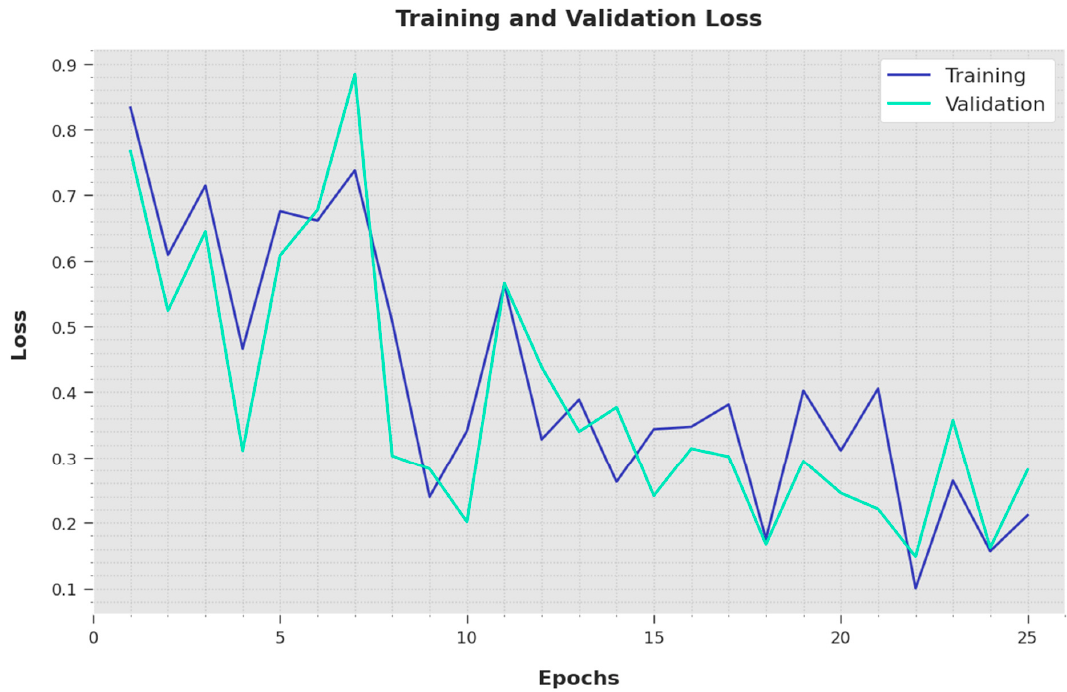
Figure 7. TL and VL analyses results of the IBESSDL-BCHI methodology.